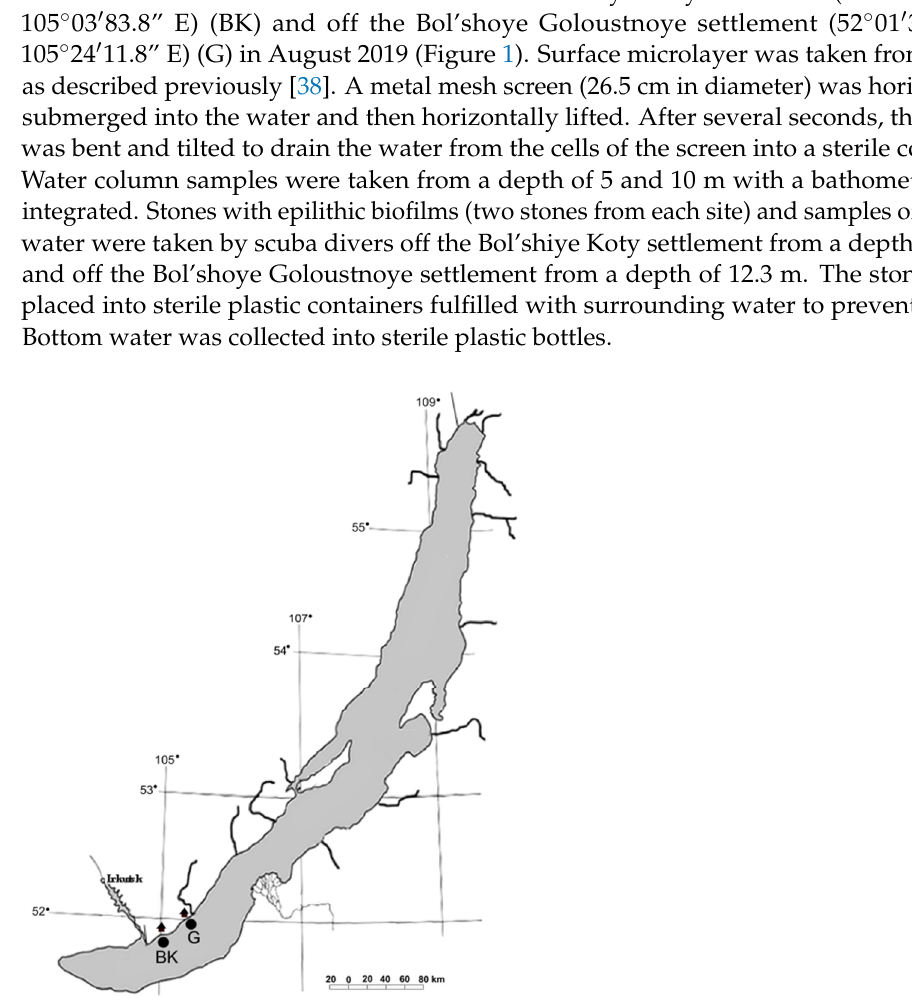
Figure 1. Sampling stations. BK—sampling station off the Bol’shiye Koty settlement; G—sampling station off the Bol’shoye Goloustnoye settlement.